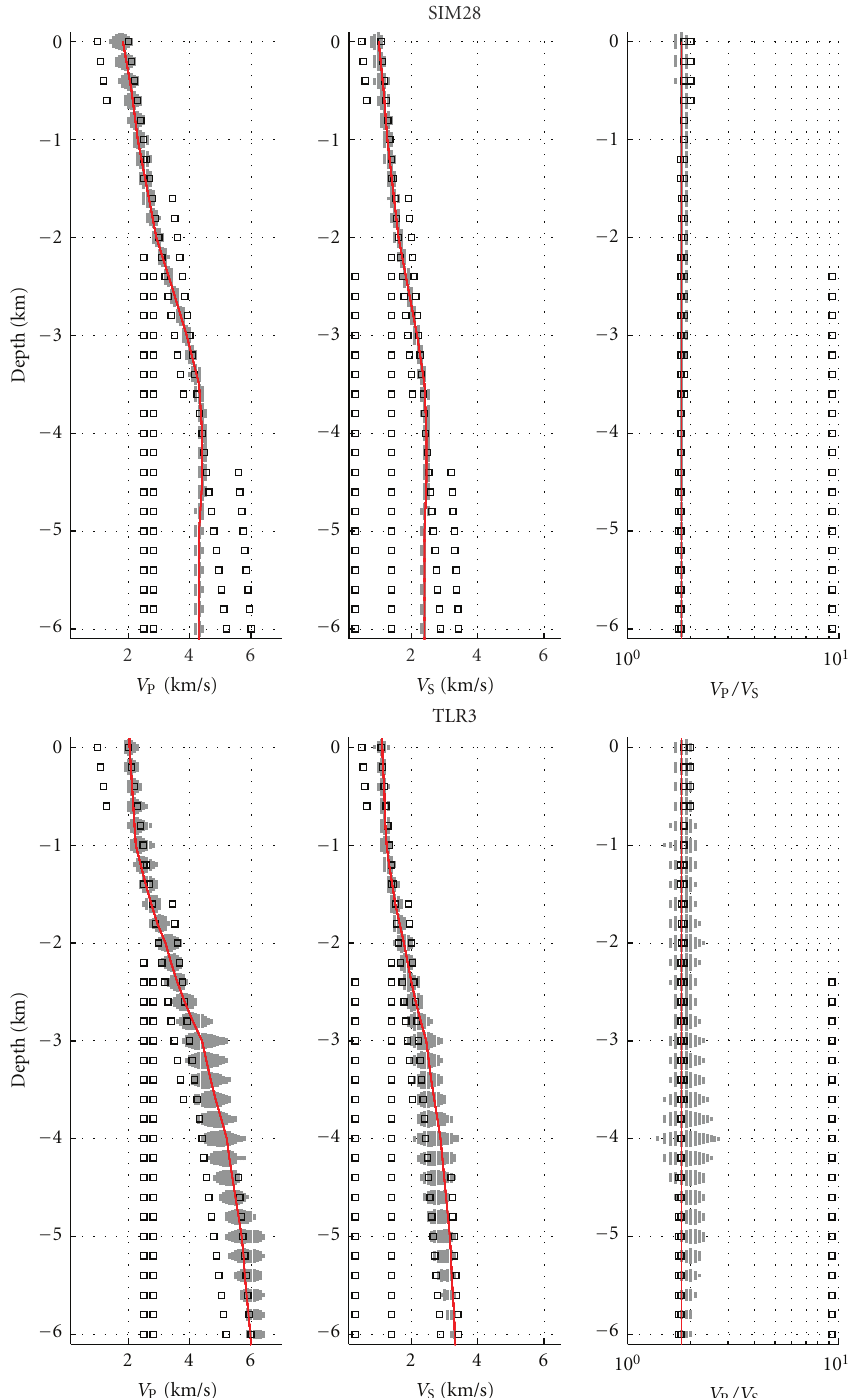
Figure 25: Mean V P , V S , and V P /V S models as a function of depth. At each depth, the average values obtained along the corresponding horizontal plane are represented. The true model is represented by black, square symbols. The inverted models are represented by grey, vertical bars, where the height of the bar (i.e., the thickness of the grey cloud) is proportional to the numerousness of the value along each plane weighted by the resolution matrix. The red line shows the initial 1D model adopted by each